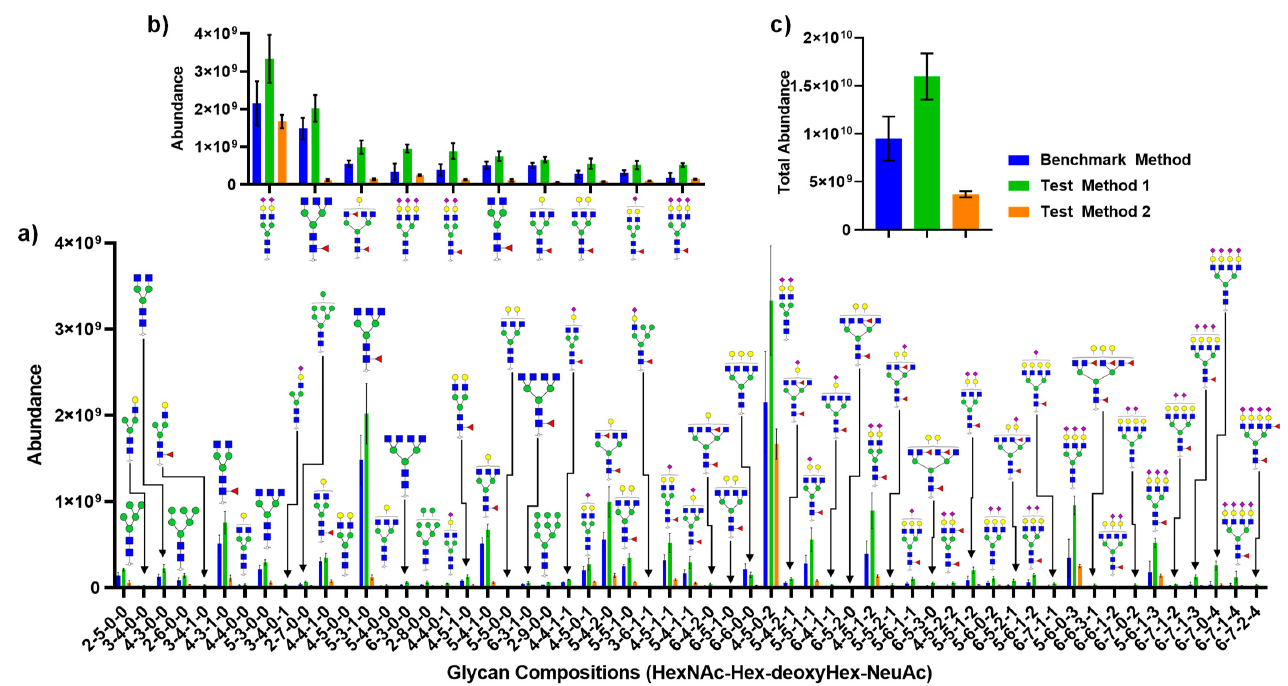
Figure 6. Quantitative analysis comparing three different methods of N -glycan release from CSF: ( a ) absolute abundance of all glycans detected; ( b ) absolute abundance of top ten most abundant glycans; ( c ) sum of total glycan abundance from each method. Glycan structures shown here are putative.